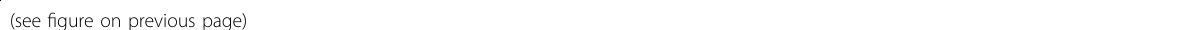
Fig. 1 SARS-CoV-2 N protein phase separates into stress granules in cells with G3BP1 and in vitro. a Prion-like domain analysis of SARS-CoV-2 N protein revealed that the N-terminal 1 – 39 aa was a probable IDR, which inclined to undergo LLPS. b Images of HeLa cells overexpressing GFP- tagged N protein (top) or N protein without the N-terminal 1 – 39 residues ( Δ N) (bottom). The left and right panels showed cells in the absence and presence of arsenite at 500 μ M for 30 min, respectively. N protein aggregated into spherical droplets of several micrometers in diameter. Scale bar, 10 μ m. c , d Fluorescence recovery of N-GFP protein after photobleaching showed that N protein demonstrated exceptional recovery in 60 s. Scale bar, 5 μ m. The error bar represents SD ( n = 18). e N-GFP protein underwent droplet fusion in a time-lapse movie after arsenite stress. Scale bar, 5 μ m. f Fluorescence images of N-GFP condensation with endogenous G3BP1. Δ N-GFP failed to phase separate into G3BP1 SGs. Arsenite was added into medium at 500 μΜ for 30 min. Scale bar, 10 μ m. As, arsenite. g Western blotting of HeLa G3BP1 knockdown cell lines showed effective knockdown by #2 and #3 shRNAs. h Statistic analysis showing that HeLa cells formed N-GFP puncta after G3BP1 knockdown with arsenite treatment for 30 min at 500 μ M. For each group of cells, more than 50 cells were calculated for each time. i Upper panel, SARS-CoV-2 N proteins were diluted at 2.5, 5, 10, 20, and 40 μ M separately in 25 mM Hepes (pH 7.5), 50 mM NaCl, and observed under bright fi eld of a confocal microscope. Lower panel, SARS-CoV-2 N protein were diluted at 2.5, 5, 10, 20, and 40 μ M separately in 25 mM Hepes (pH 7.5), 50 mM NaCl with additional 6.25 ng/ μ L total RNAs from HeLa cells. Droplets were observed under a bright fi eld of a confocal microscope. Scale bar, 10 μ m. j N protein at 10 μ M in 25 mM Hepes (pH 7.5), 50 mM NaCl were stimulated with increased concentration of total RNAs. Scale bar, 10 μ m. k FITC-labeled N protein were observed under 488 laser at different concentrations with or without RNA stimulation. The concentration of added HeLa cell total RNAs was 25 ng/ μ L. Scale bar, 10 μ m. l Left, N proteins at 10 μ M were stimulated with 6.25 ng/ μ L HeLa cell total RNAs in 25 mM Hepes (pH 7.5), 50 mM NaCl; right, the salt concentration of the left protein solution was raised to 500 mM and droplets dissolved. Scale bar, 10 μ